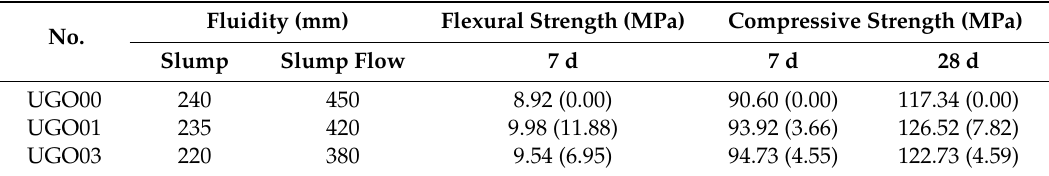
Table 3. Fluidity, flexural strength, and compressive strength of ultra-high strength concrete (UHSC) with different content of GONSs. The UHSC samples containing 0.00%, 0.01%, and 0.03% bwoc GONSs are numbered as UGO00, UGO01, and UGO03, respectively.